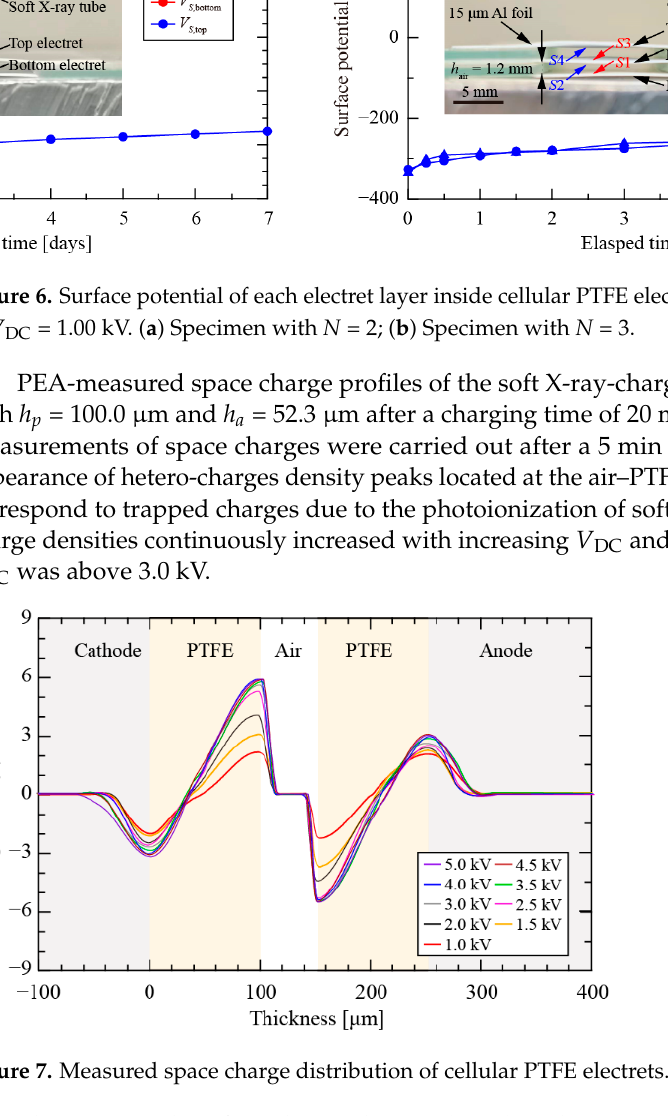
The negatively charged top electret surface had a slightly higher charge density than that of the bottom surface. The experimental and the calculated surface charge densities are in good agreement within a short charging time, but obvious differences were observed after 3 min, which can be attributed to insufficient photoionized gas inside the enclosed cellular structure. In addition, as discussed previously, it is impossible to reach the theoretical saturation ( σ ) because charge carriers require a sufficient electric field to be injected into the electret layer.